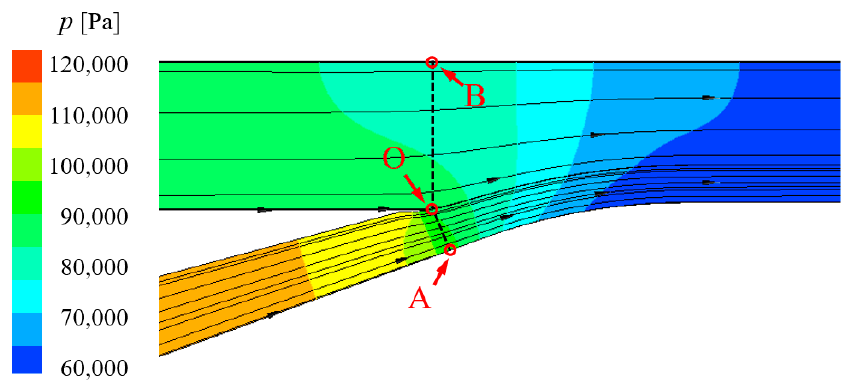
Figure 5. Streamlines and static pressure distribution of the combining flow ( A VABI = 0.6, α VABI = 25°, and p out = 0.6).